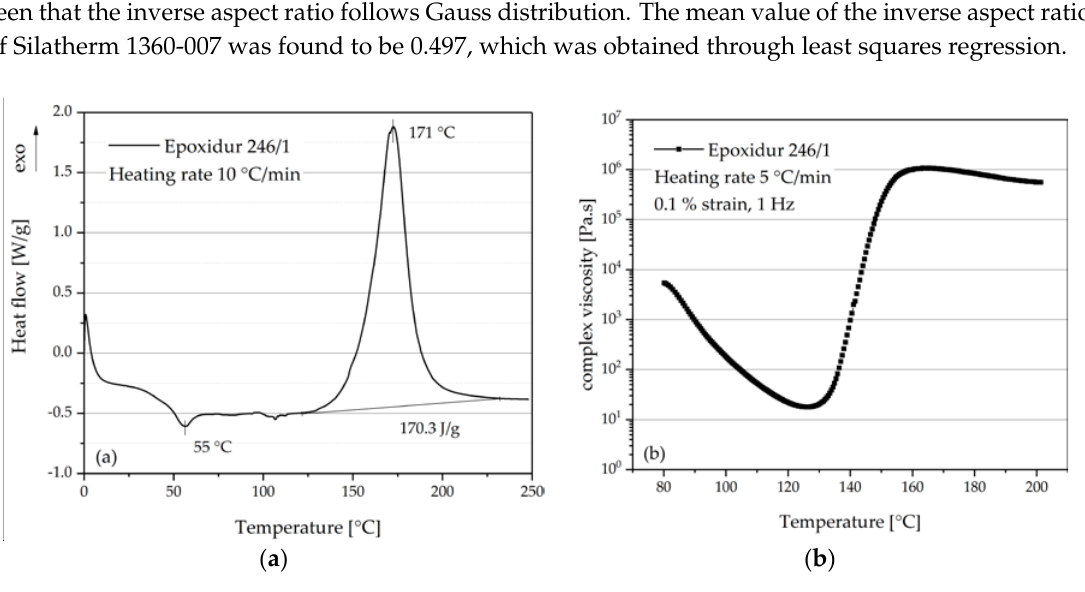
Figure 3. ( a ) thermal analysis of EP with differential scanning calorimetry (DSC); ( b ) complex viscosity of EP as function of temperature.